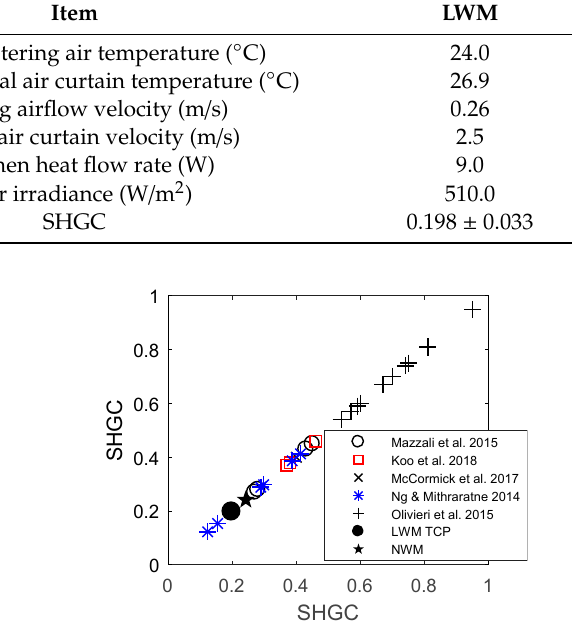
Figure 15. Experimental SHGCs.